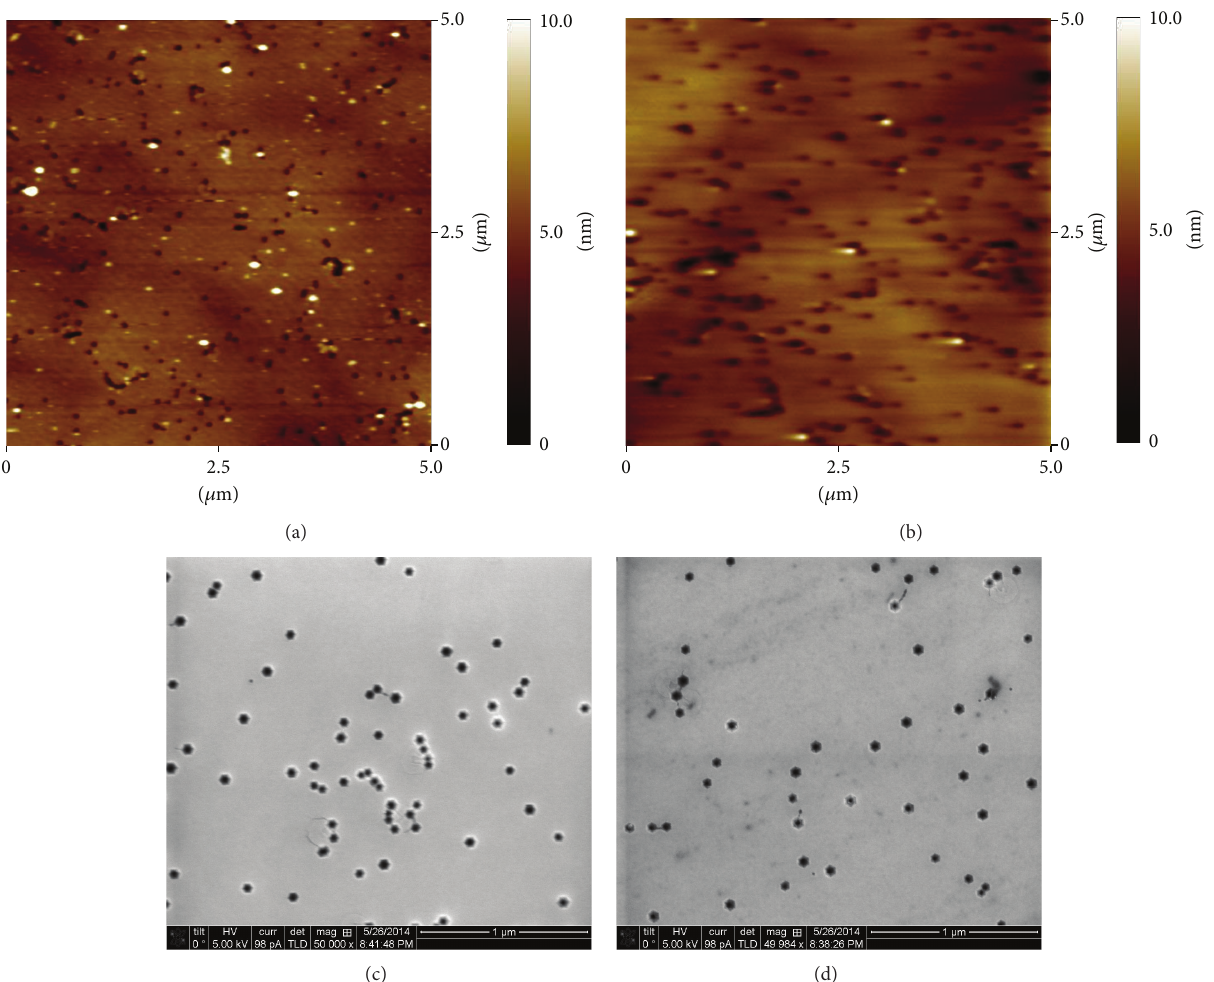
Figure 3: AFM and SEM images of the surface morphologies of the (a), (c) sample without TMIn treatment and (b), (d) sample with TMIn